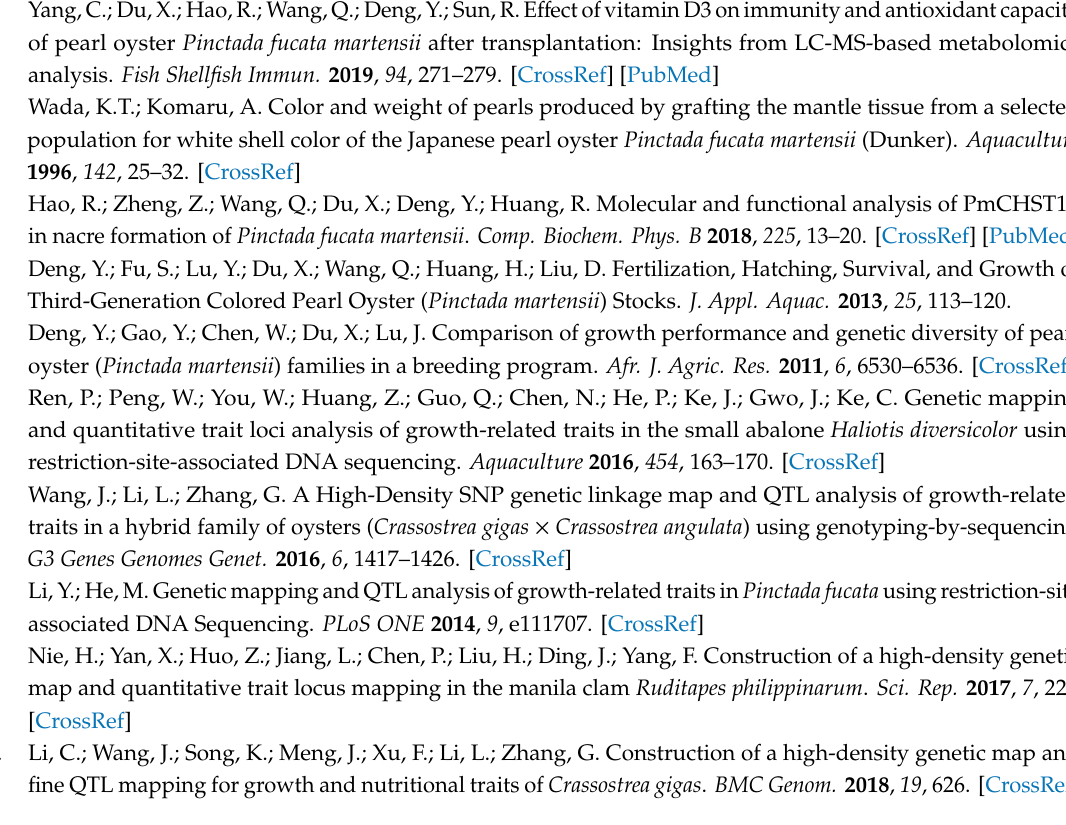
Figure S1: Nucleotide sequence analysis of PmFGF18 , Figure S2: Phylogenetic tree of FGF18 among di ff erent species. Figure S3: Expression pattern of PmFGF18 during development in the development